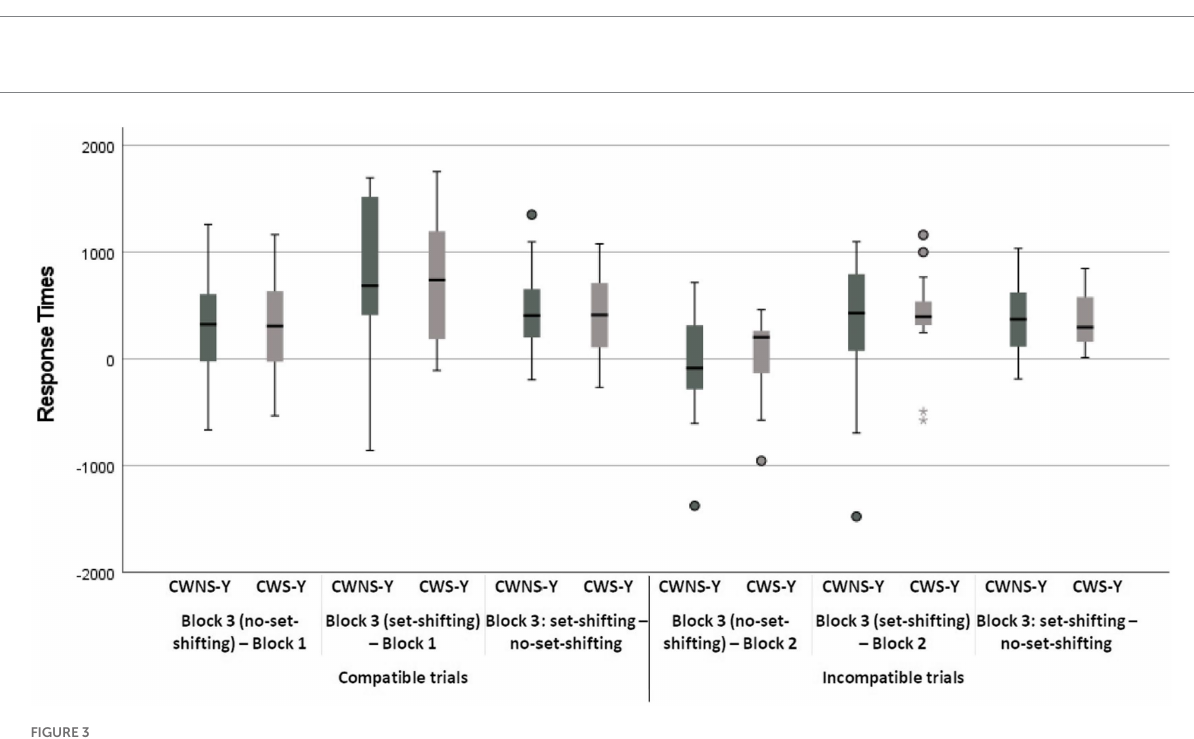
FIGURE 3 Boxplots of costs in response times for CWS-Y and